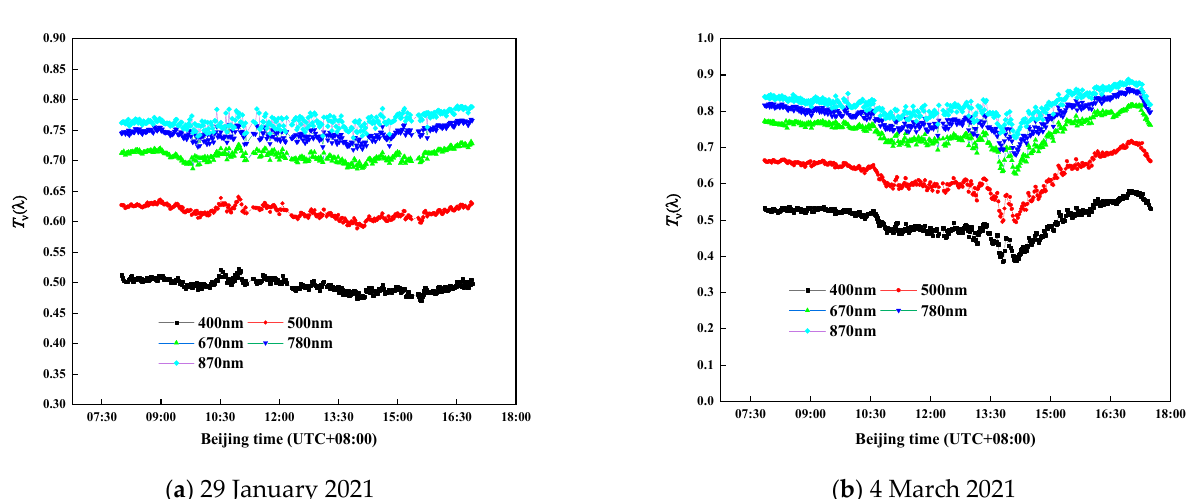
Figure 14. Atmospheric transmittance of five typical wavelengths during the course of a day.